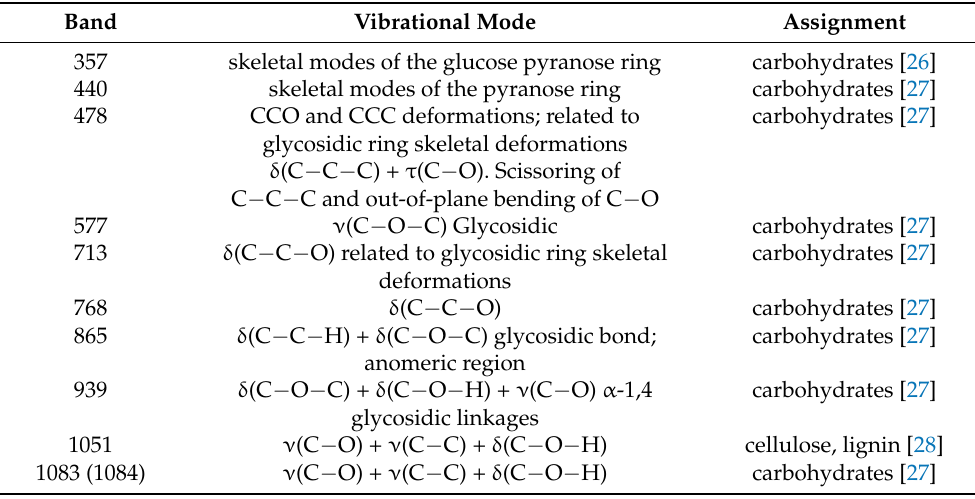
Figure 6. FT-Raman spectra show the chemical composition of seedling’s endosperm of maize ( A ) and barnyard grass ( B ) that were growing on the surfactants (S1, light orange line, and S5, dark orange line), nanoemulsions with peppermint oil (PN1, light blue line; PN2, cyan line; PN3, dark blue line; PN4, violet line) and water (C, green line). The mean values were based on six repetitions. Hierarchical cluster analysis of the FT-Raman spectra of the maize ( C ) and barnyard grass ( D ). Surfactants S1 (1% v / v ) and S5 (10% v / v ), nanoemulsions with peppermint oil PN1 (1% v / v ), PN2 (1.5% Table 3. Vibrational bands and their assignments for maize and barnyard grass.